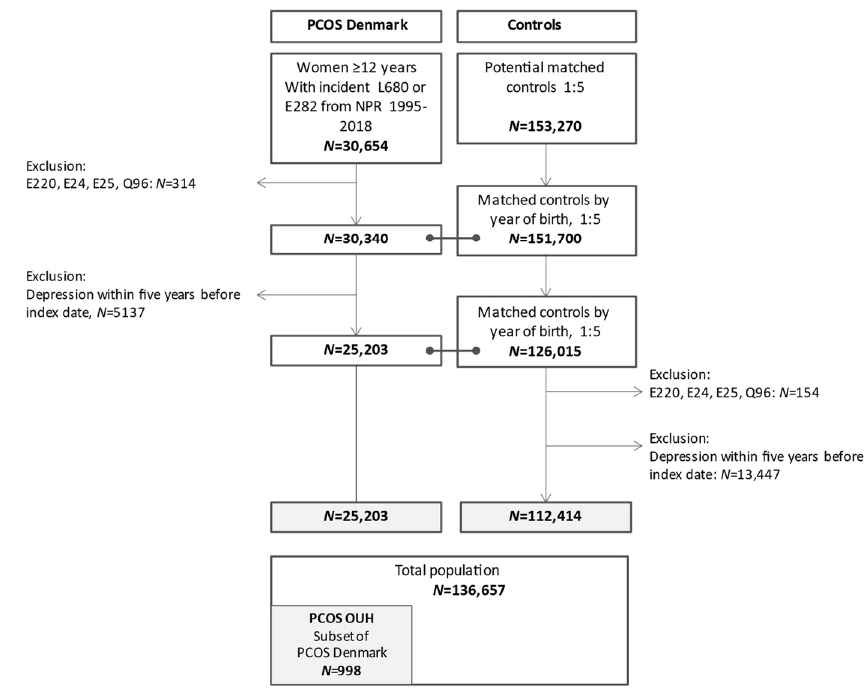
Figure 1. Flowchart of all included women with PCOS and controls.